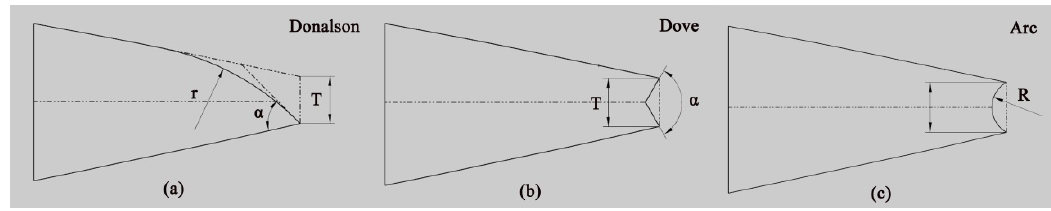
Figure 3. Profiles of improved trailing edges: ( a ) Donaldson trailing edge; ( b ) Dove trailing edge; and ( c ) Arc trailing edge.